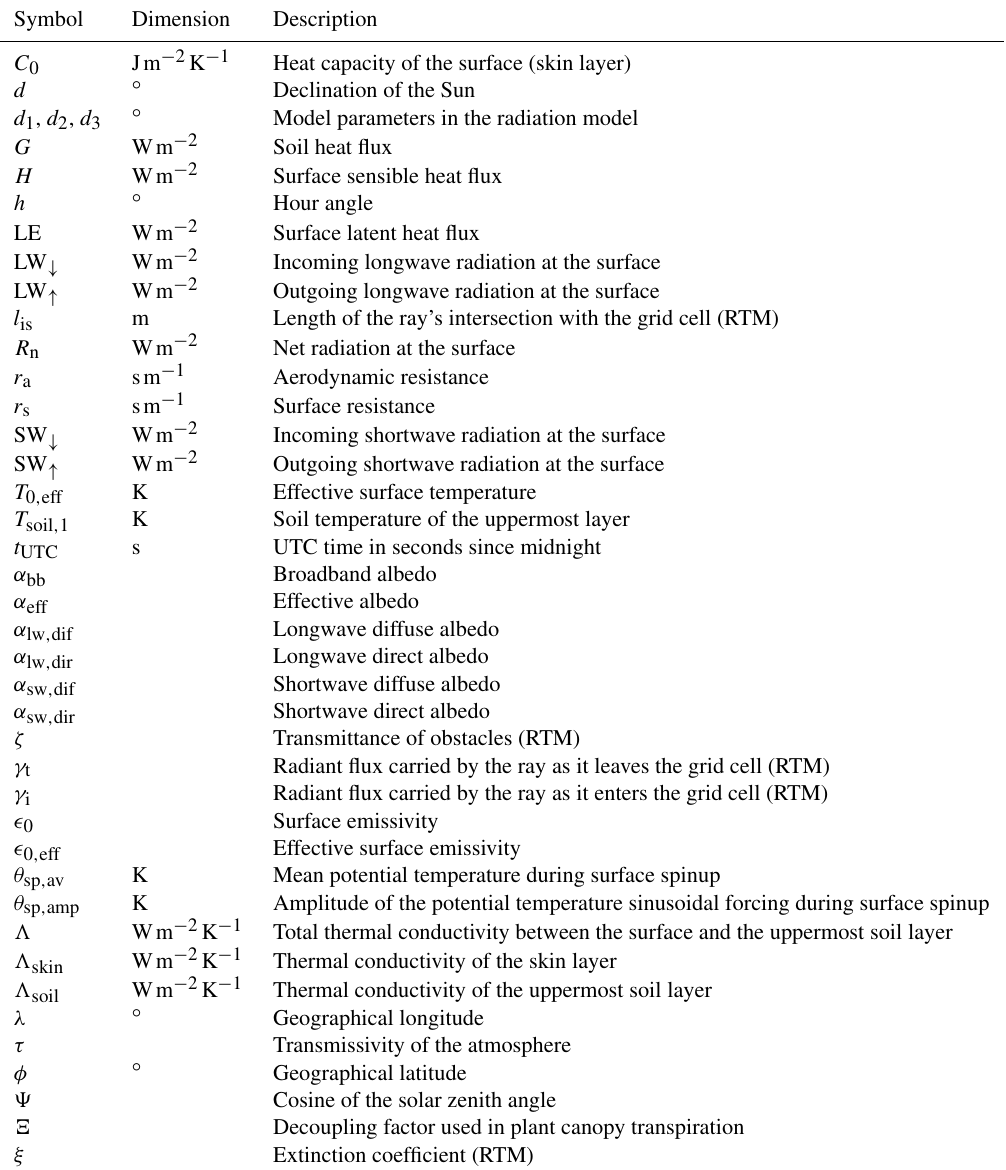
Table 6. List of symbols related to radiation and the surface energy balance.